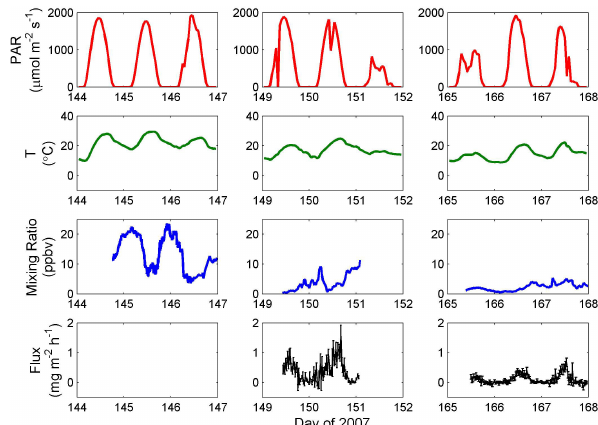
Fig. 9. Time series of methanol mixing ratio and flux during the spring of 2007. Also shown are PPFD and